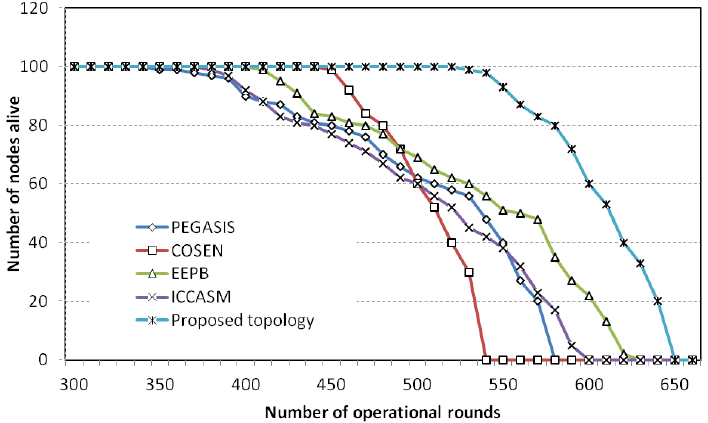
Figure 23. Lifetime comparisons among PEGASIS, COSEN, EEPB, ICCASM, and the proposed topology.